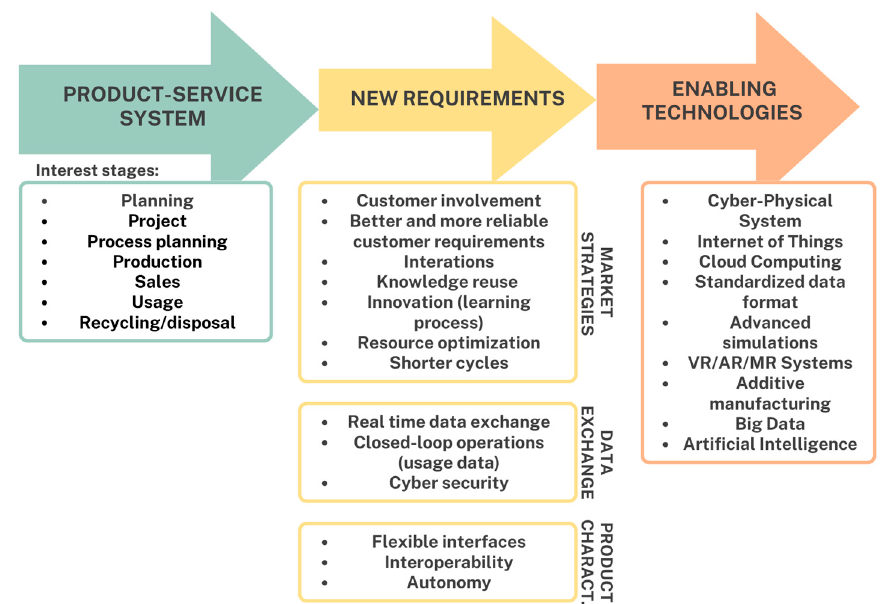
Figure 2. User-centered design philosophy: strategic key points and related technologies.